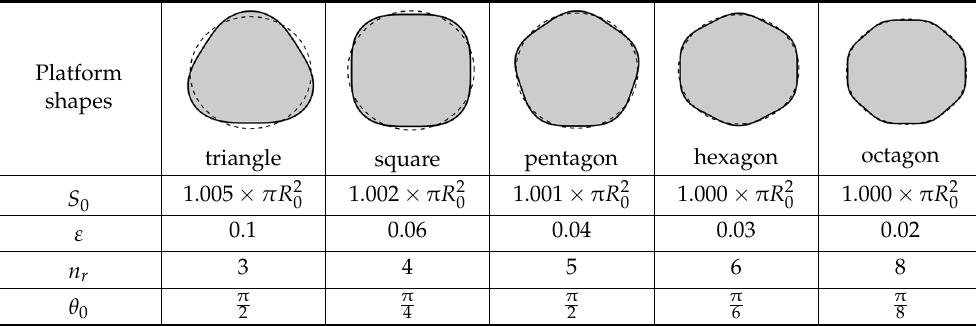
Figure 1. Floating polygonal platform under wave action.